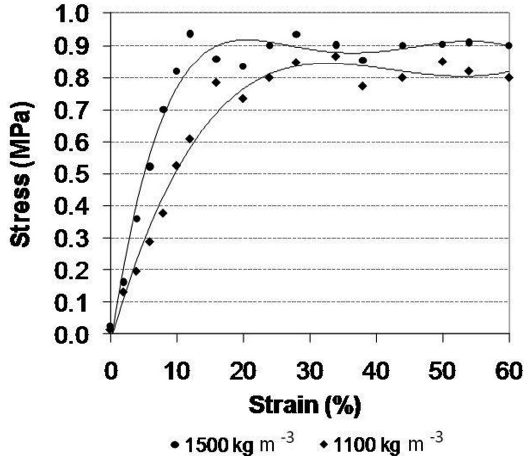
Figure 6. Stress-strain response curves of the two ceramic foams obtained. Standard deviations were 0.05 MPa for the sample made with the foam of 1100 kg m -3 and 0.07 MPa for the sample made with the foam of 1500 kg m -3 .